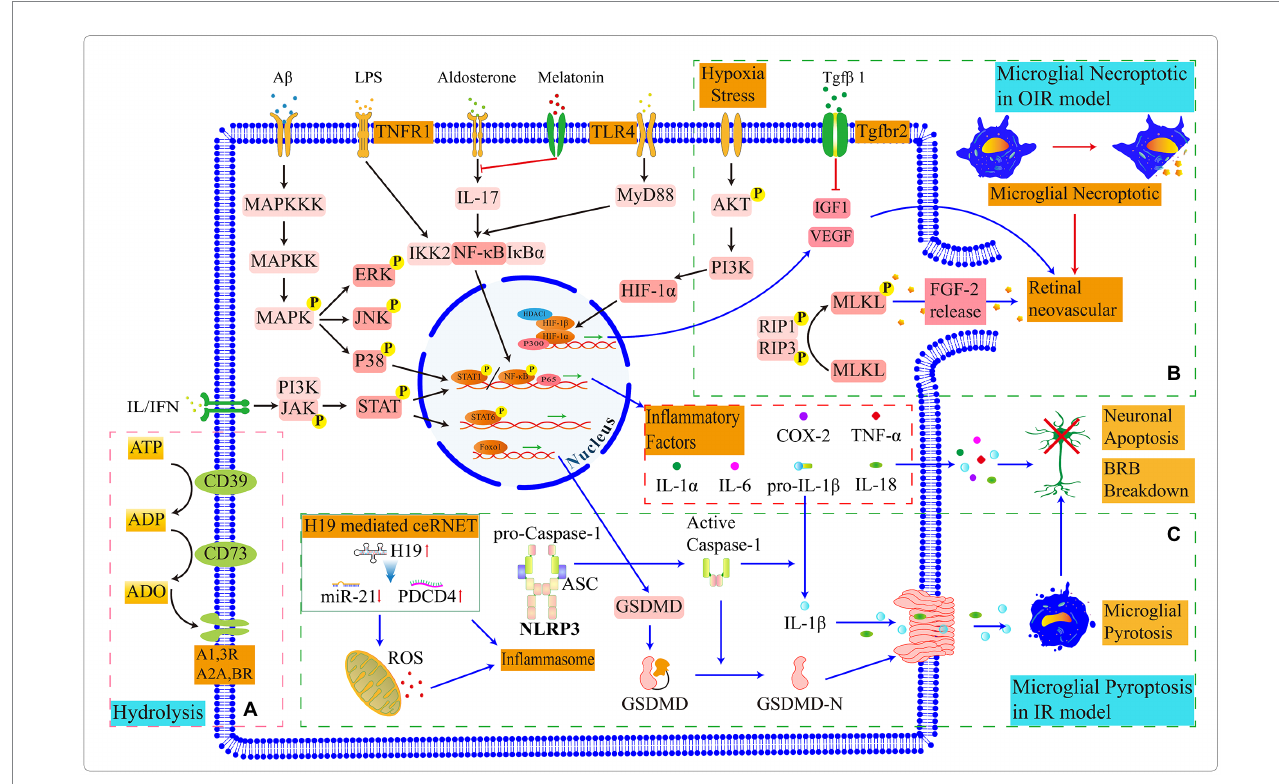
FIGURE 5 Schematic diagram of partly signal pathways in retinal microglia. (A) Microglia express CD39 and CD73 that progressively hydrolyze ATP to ADO together. (B) In the OIR model, microglial necrosis promotes the leakage of FGF, which stimulates retinal neoangiogenesis. Microglia express proangiogenic factors to promote retinal vascular proliferation, and the binding of (C) In the IR model, a competing endogenous RNA network (ceRNET) stimulates microglial pyroptosis. The maturation of pro-caspase1 in inflammasome and the activation and assembly of GSDMD protiens lead to the leak age of inflammatory factors, which ultimately result in the apoptosis of retinal neurons and damage to the BRB. The switching status of microglial signal pathways in different retinal environments and the target genes in upstream and downstream need to be further